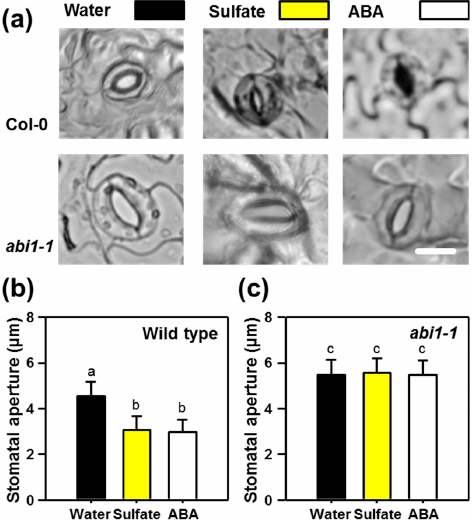
Figure 2. Functional ABI1 is required for stomatal closure upon ABA or sulfate treatment. ( a ) Representative guard cell in epidermal peels of 5-week–old soil-grown wild-type and abi1-1 plants that were floated on water at pH 5.5 or water supplemented with sulfate (15 mM MgSO 4 ) or ABA (50µM) for three hours. ( b-c ) Quantification of the stomatal aperture in epidermal peels of the wild- type (b) and the abi1-1 mutant (c) that were treated with water (control, black) supplemented with sulfate (15 mM, yellow) or ABA (50 µM, white). Letters indicate statistically significant differences between groups determined with the one Way ANOVA test ( P <0.05, n = 50 stomata, derived from epidermal peels of five individual plants). Values represent means + standard deviation (SD). Scale bar, 10 µm.